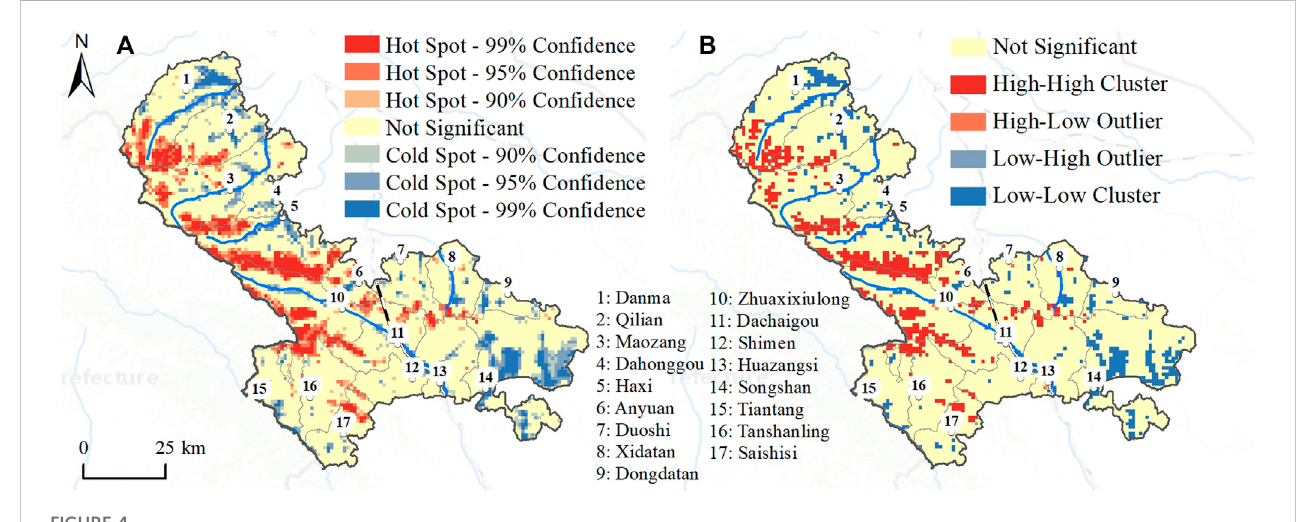
FIGURE 4 (A) Hot spot and (B) LISA detection of the ecological security evaluation